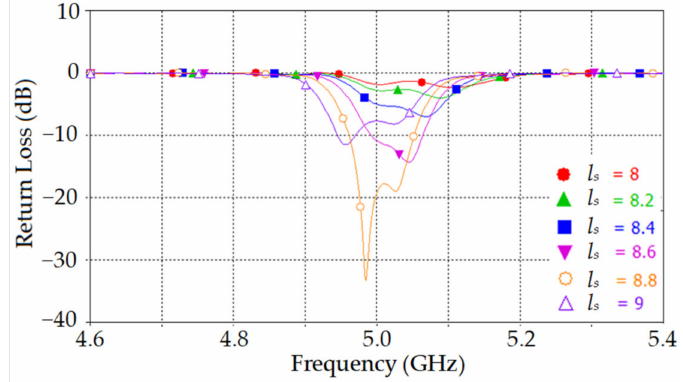
Figure 5. Simulated return loss for different values of ‘ l s